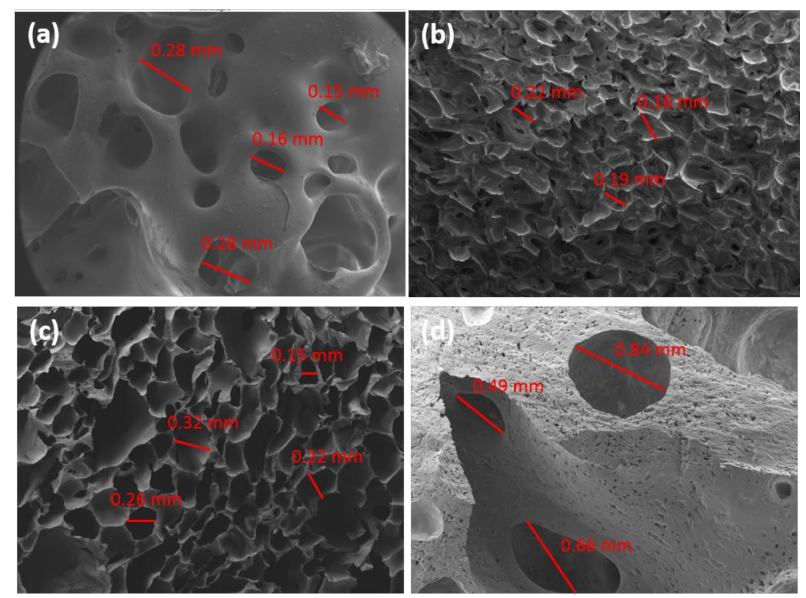
Figure 5. SEM images of ( a ) BM, ( b ) 80:20M, ( c ) 60:40M, and ( d ) 50:50M foams.